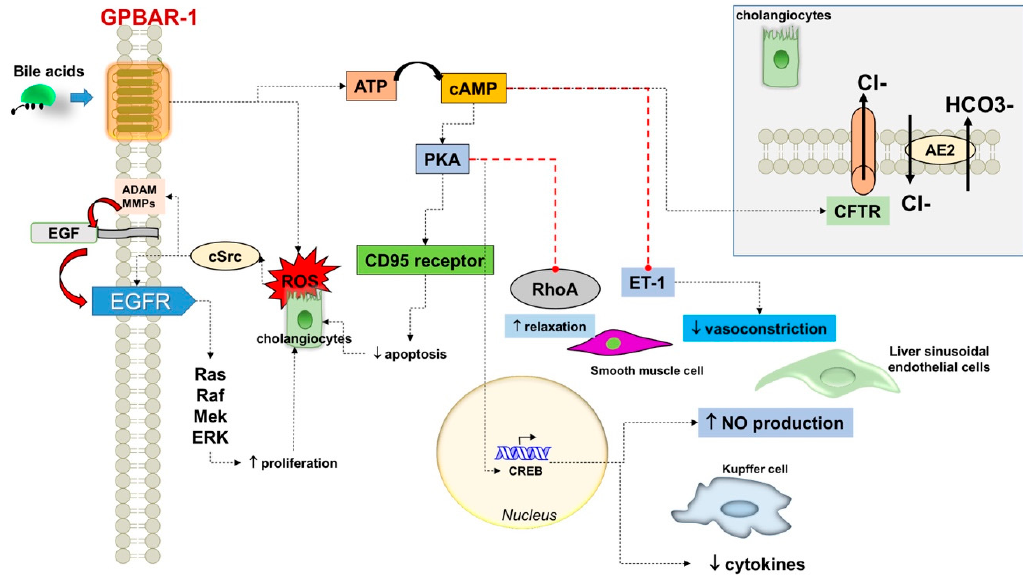
Figure 4. Additional effects of G protein-coupled bile acid receptor 1 (GPBAR-1) stimulation.